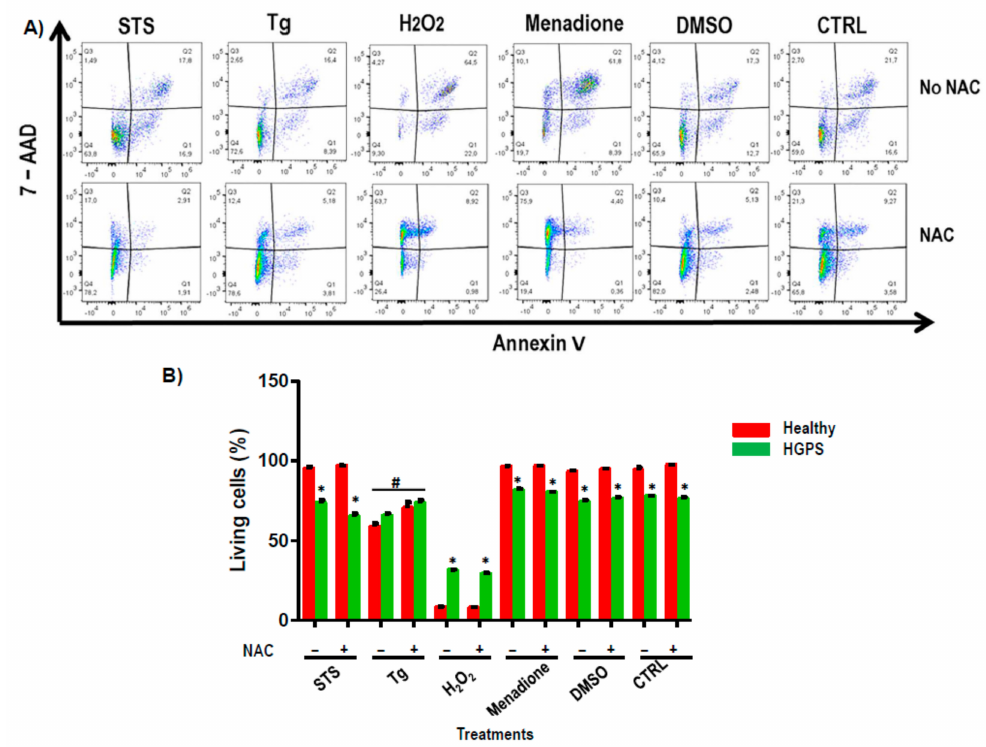
Figure 7. Apoptosis study. Flow cytometry from healthy (AG03257, AG03258, AG03512, and AG06299) and HGPS (AG03198, AG03199, AG03513, and AG06917) human skin fibroblasts treated with and without NAC. ( A ) Representative FAC profile showing the 7-ADD in front of Annexin V staining using FlowJo software V8.6 (Treestar, OR, USA) from HGPS skin fibroblasts treated with or without NAC. ( B ) Histograms represent the percentage of living cells with the different treatments. Bars are means ± SEM from three independent experiments. * p < 0.05 was considered statistically significant versus healthy cell lines. # p < 0.05 was considered statistically significant versus treatments. STS = staurosporine; Tg = thapsigargin; H 2 O 2 = hydrogen peroxide; DMSO = dimethyl